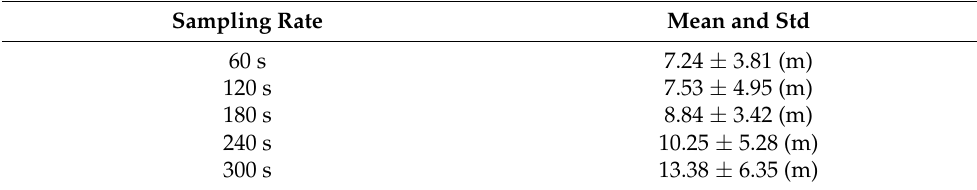
Table 2. Errors between the corrected GPS points and the real GPS